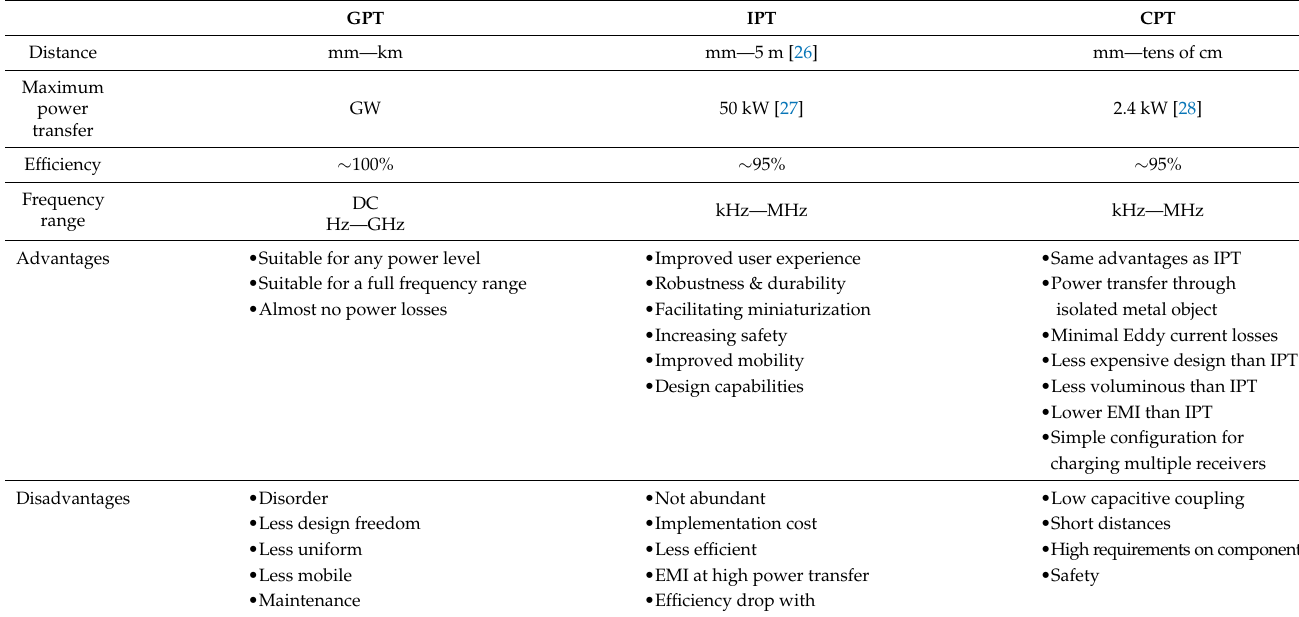
Table 1. Comparison of the main properties of GPT, IPT CPT.